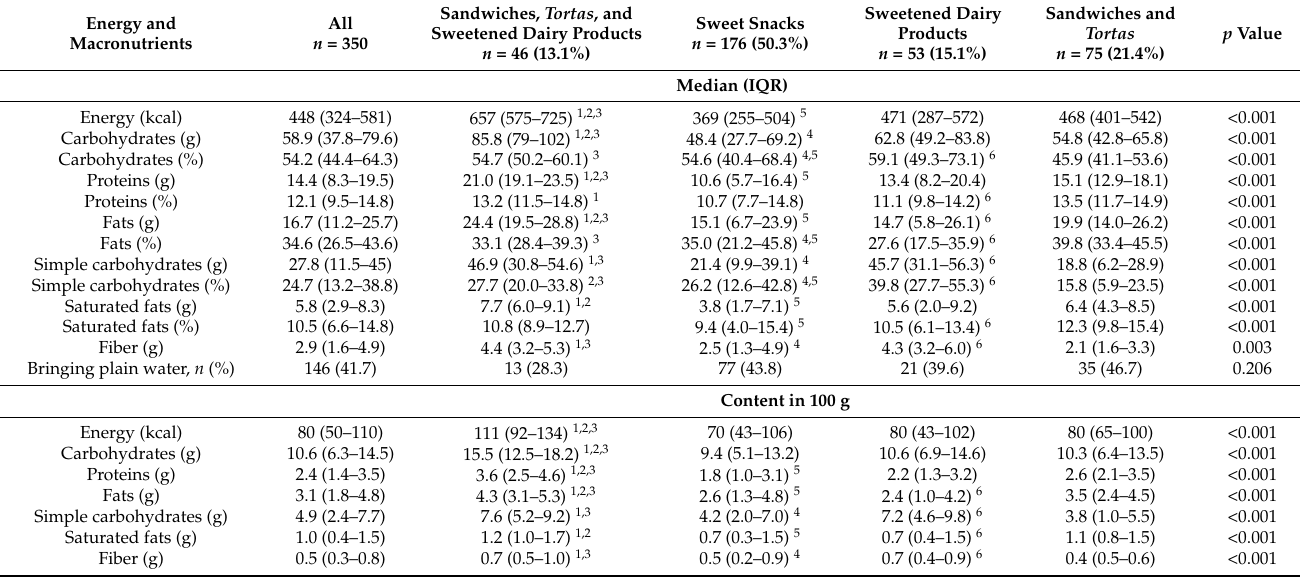
Table 2. Energy and macronutrient contribution by dietary patterns.